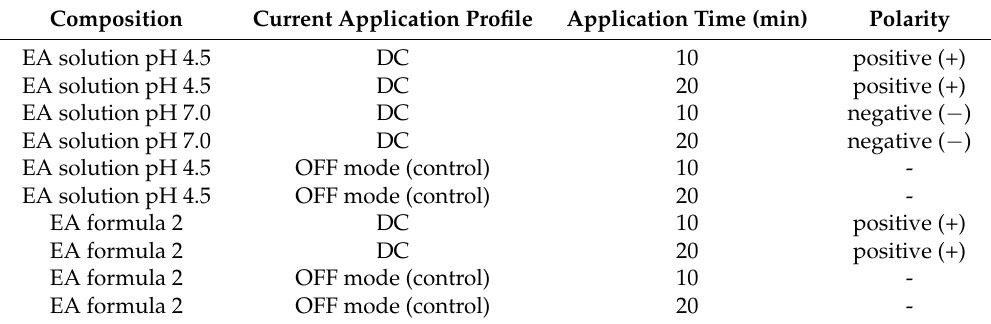
Table 3. Experimental conditions of EA assessment ( n =